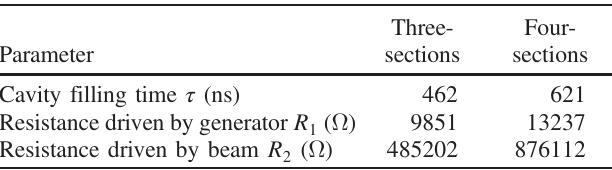
FIG. 2. Three-section cavity. Left: Z